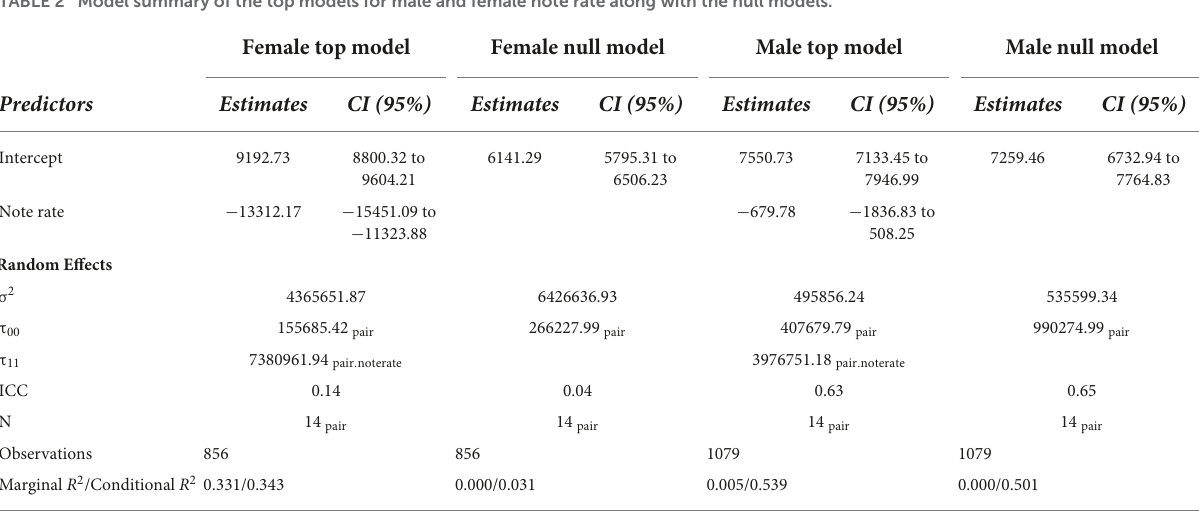
TABLE 2 Model summary of the top models for male and female note rate along with the null